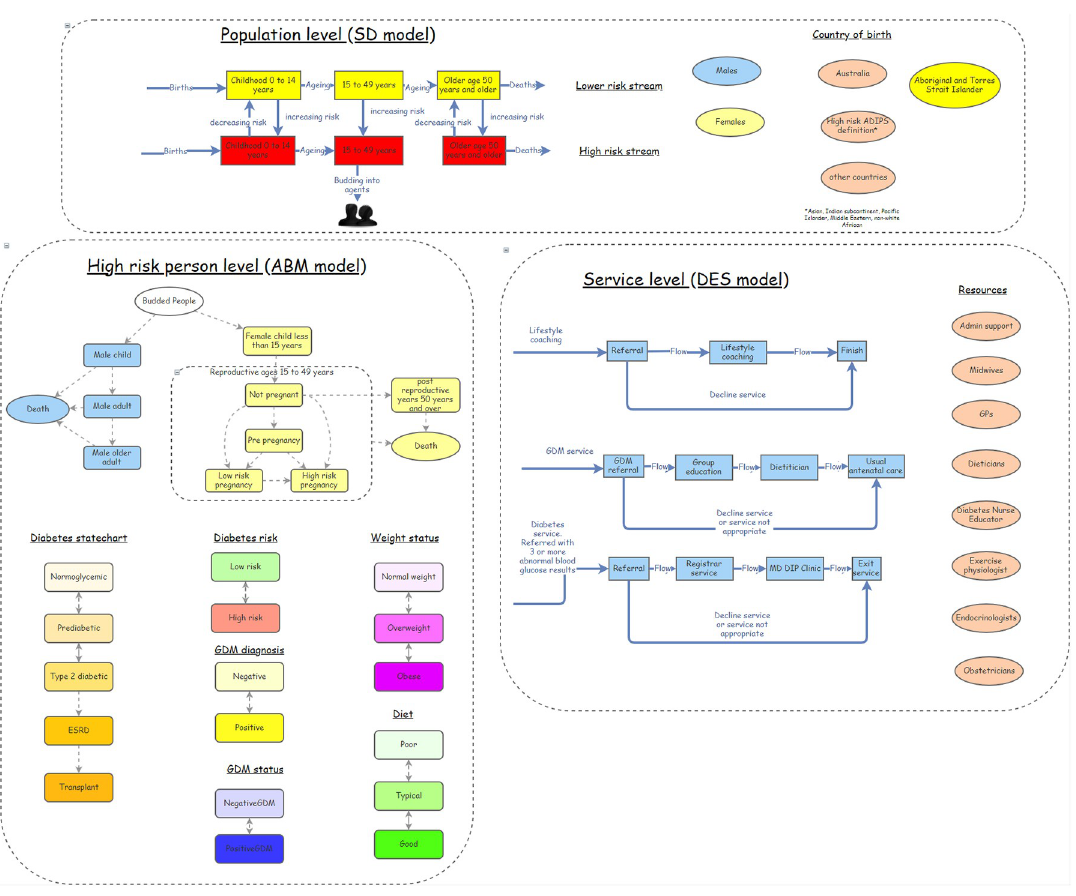
Fig 4. Simplified model structure presented in workshop